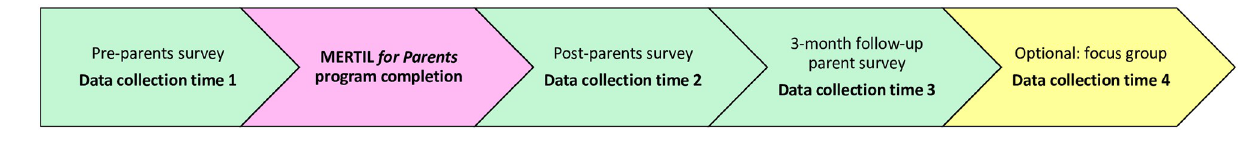
Fig 5. Flow diagram of MERTIL for Parents parent data collection